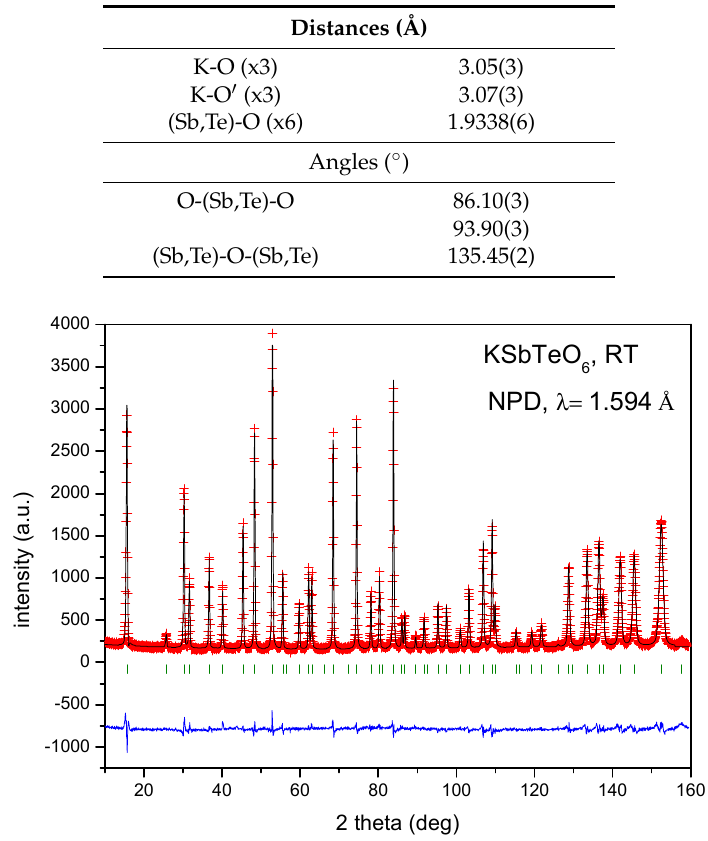
Table 2. Selected interatomic distances and angles for KSbTeO 6 at 298 K.